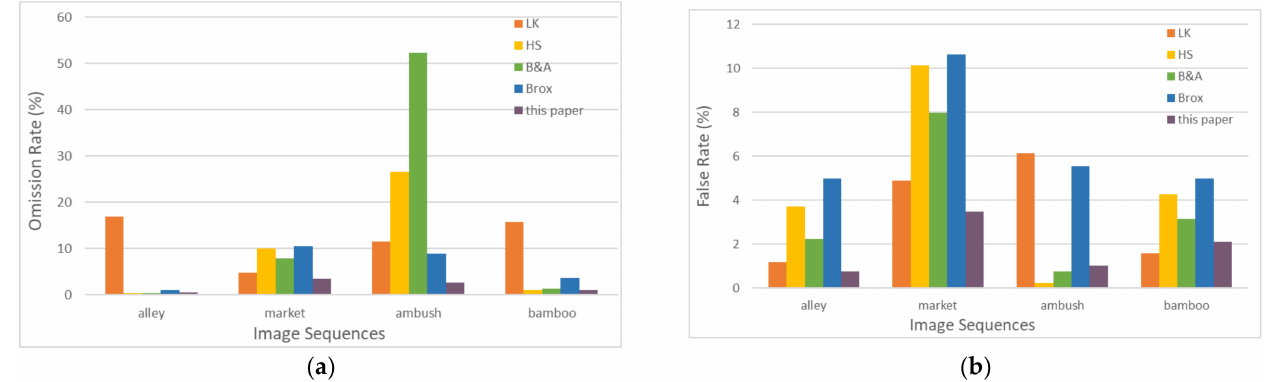
Figure 6. The MPI image sequence motion foreground target detection result error comparison results: ( a ) A comparison of the omission rate; ( b ) a comparison of the false rate.